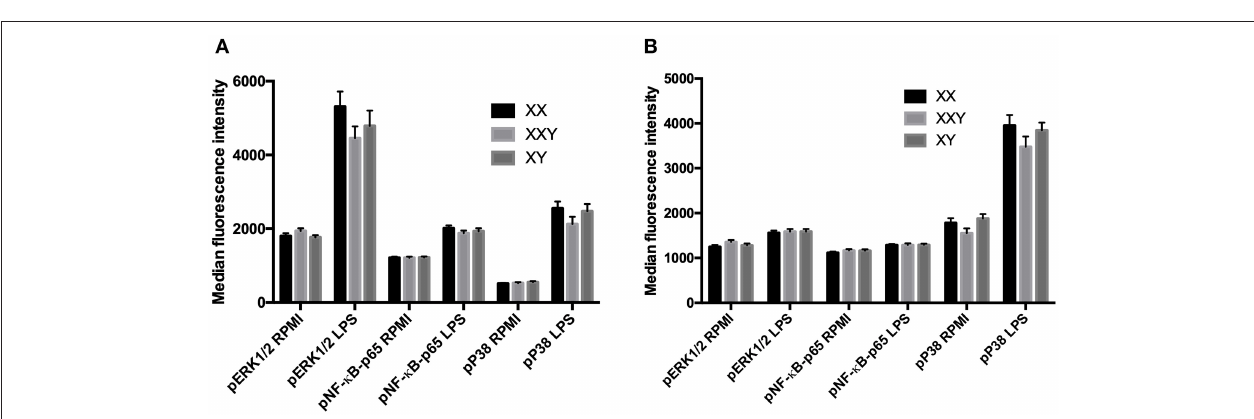
FIGURE 5 | Mean ± SEM of the median fluorescence intensity of phospho-ERK1/2, phospho-NF- κ B-p65 and phospho-P38-MAPK in monocytes (A) and neutrophils (B) , before and after stimulation of whole blood with LPS 10 µ g/mL in men, women, and subjects with Klinefelter syndrome. Whole blood was stimulated with LPS at 10 µ g/mL for 15min. Reactions were stopped, and red blood cells removed. After washing, cells were permeabilized and mixed with fluorochrome-conjugated monoclonal antibodies against the phosphorylated kinases. The median fluorescence intensity of each fluorochrome was measured in each leukocyte population by flow cytometry. BD FACSDiva TM software version 6.1.2 for Windows was used to acquire the data and BD FCAP Array TM software version 1.0.1 for Windows was used to analyze the data.